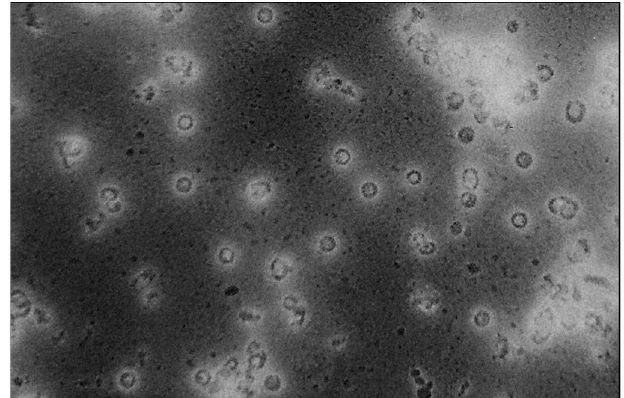
Figure 3. BPV1 L1 virus-like particles (VLPs) used for immunization of horses. Visualization of uranyl acetate-stained BPV1 L1 VLPs by transmission electron microscopy at 30,000 × magnification. VLPs were expressed in insect cells and purified on density gradients. This photograph was kindly provided by Saeed Shafti-Keramat from the Medical University of Vienna.